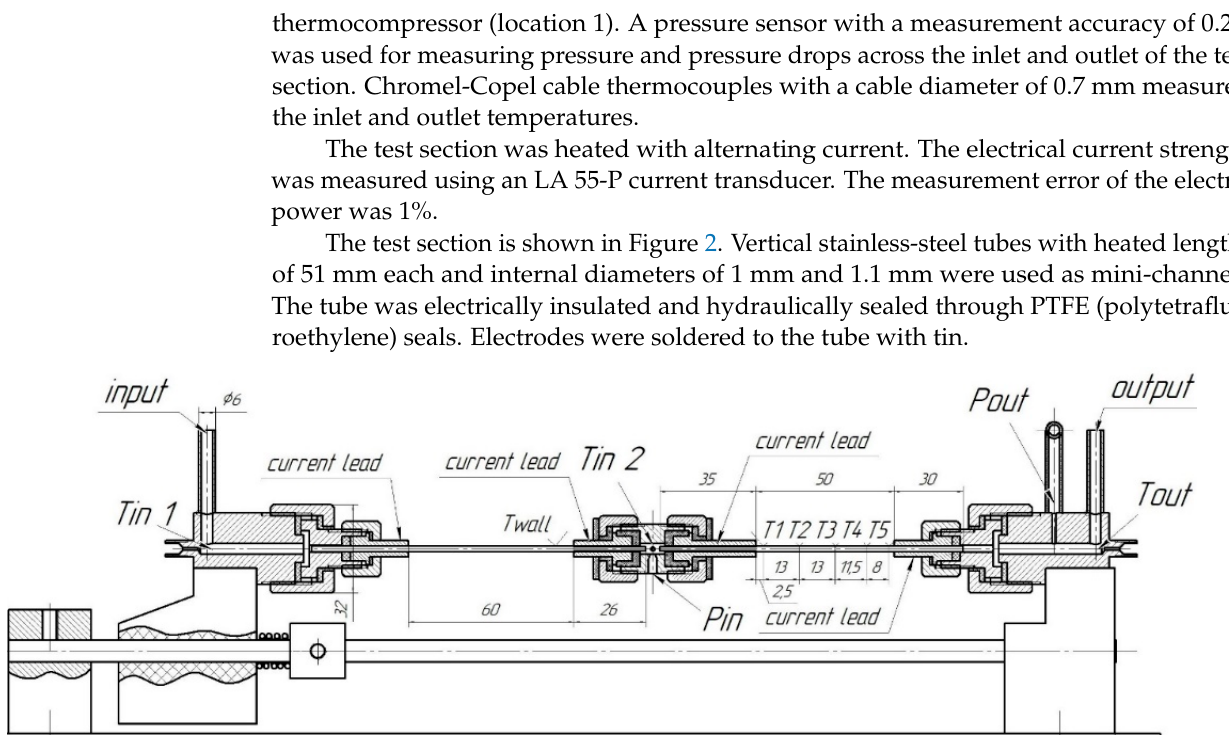
Figure 2. Design of the test section.